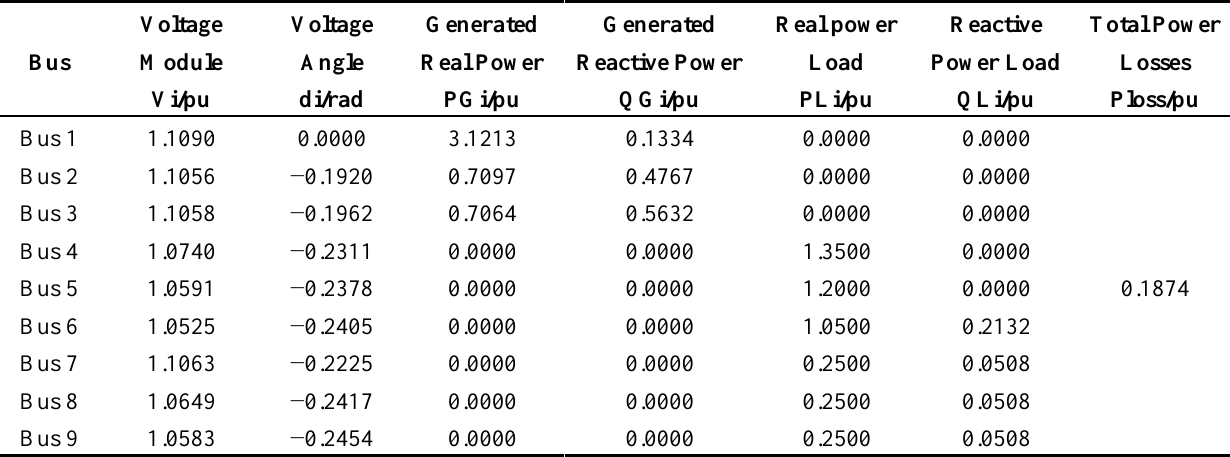
Table 2. Initial operating